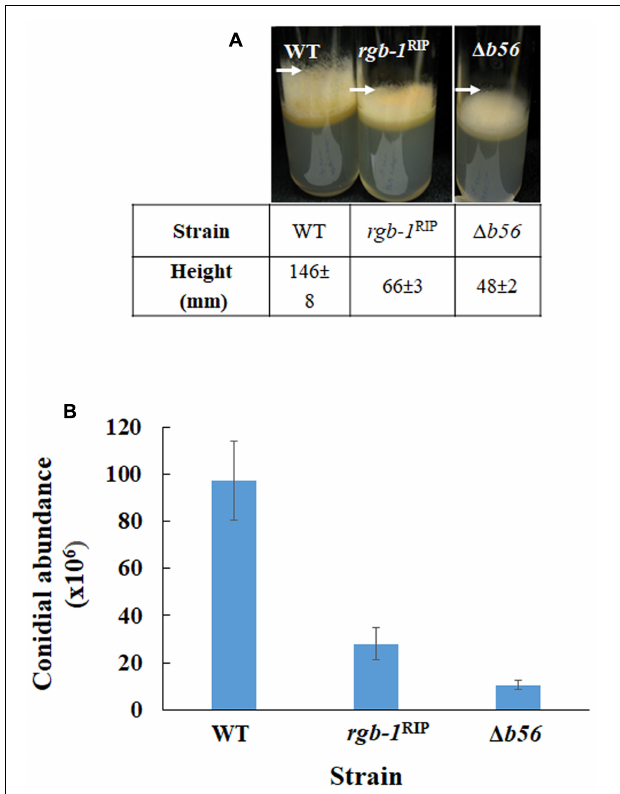
FIGURE 5 | The PP2A regulatory subunits rgb-1 and b56 are required for proper aerial hyphae formation and conidiation. (A) wt, rgb-1 RIP , and (cid:49) b56 strains grown in test tubes at 34 ◦ C for 3 days. Height of the aerial hyphae of the different strains is indicated. (B) Conidial abundance in the regulatory subunit mutants. Bars indicate standard